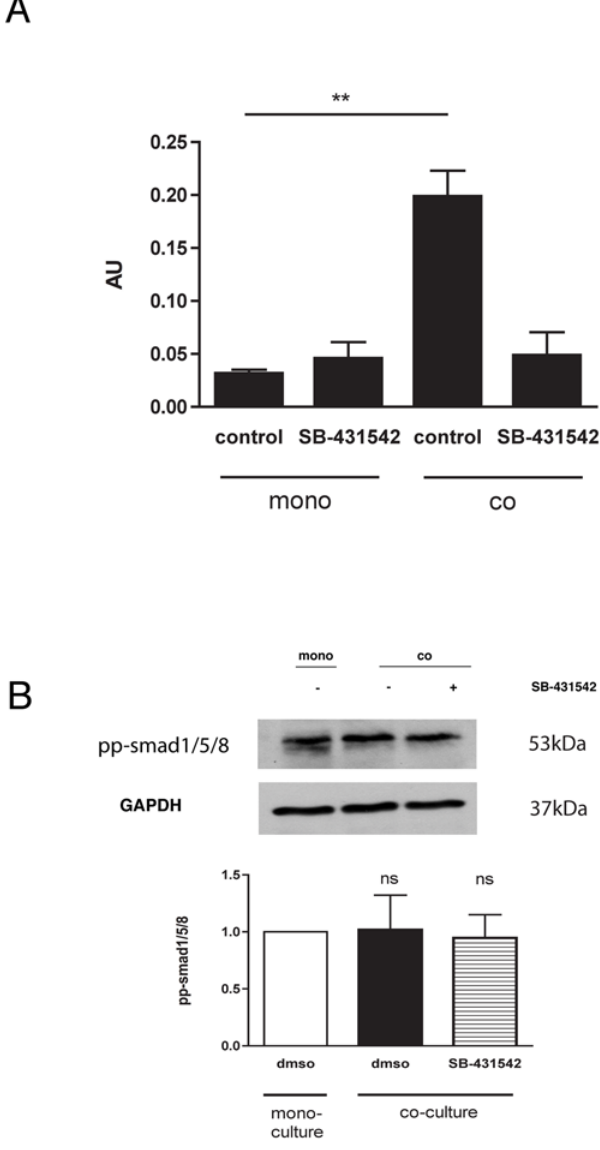
Figure 4. Co-culture of endothelial/mesenchymal cells acti- vates endothelial smad2/3 signaling. (A) Transient transfection of ECs with CAGA-Luc smad2/3 reporter revealed that co-culture with 10T1/2 cells activated smad2/3 signaling. Pharmacological inhibition of TGF- b with 10 m M SB-431542 reversed this activation. (B) Co-culture of ECs with 10T1/2 cells did not alter phosphorylation of EC